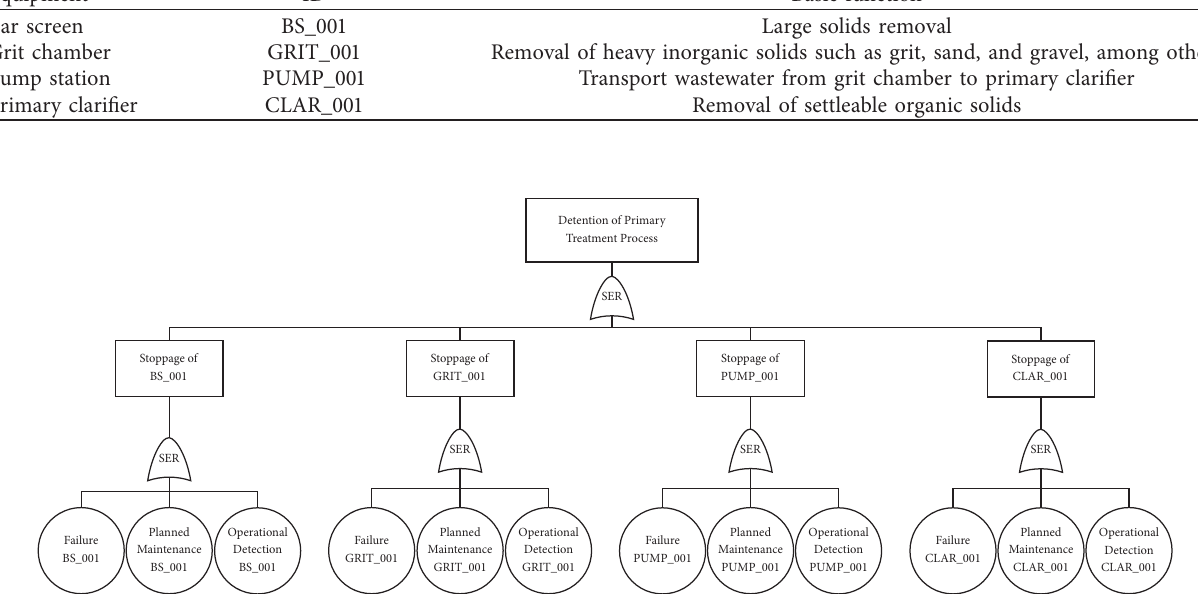
Figure 5: FT representation of the primary treatment process-immediate effect.